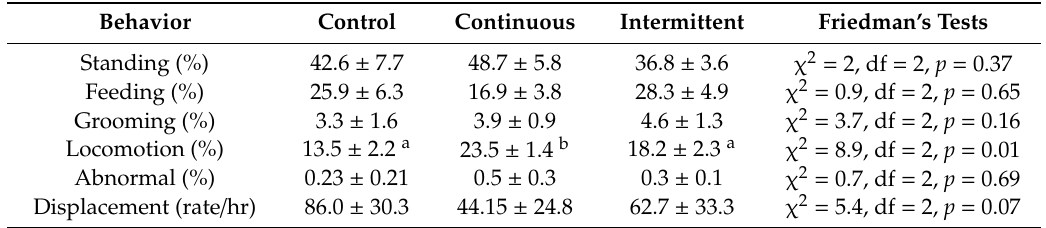
Figure 6. Boxplots of alligator behavior in control, continuous and intermittent noise conditions with symbols identifying individuals. Table 2. Mean ± SE of behavioral categories from giraffes (n = 3), elephants (n = 2), and emus (n = 2) during three sound conditions (control, continuous exposure to construction noise, intermittent exposure to construction noise). All means are % of time, except for displacement behavior which is rate/hr. Statistically significant differences between groups (using Wilcoxon signed-rank tests) are indicated by superscript (Di ff erent letters indicate p <